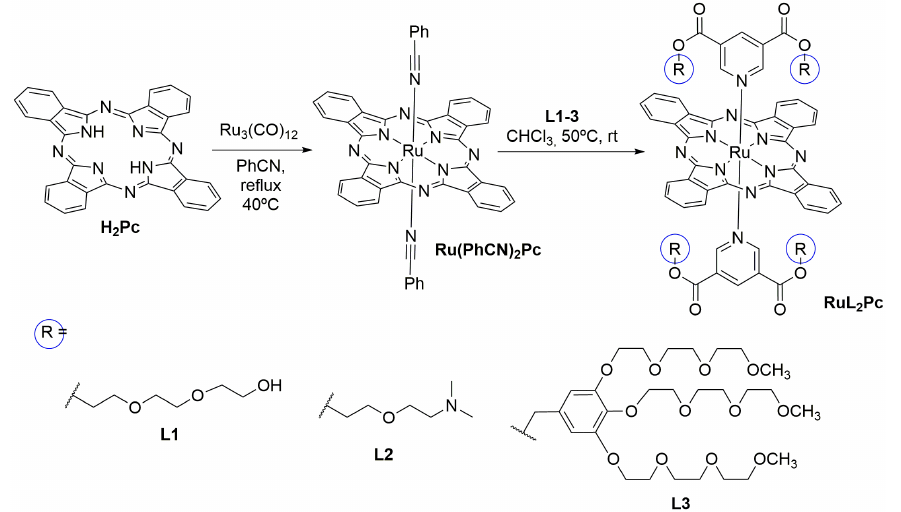
Figure 27 - Synthetic strategy for PEG-containing ruthenium phthalocyanines (RuL